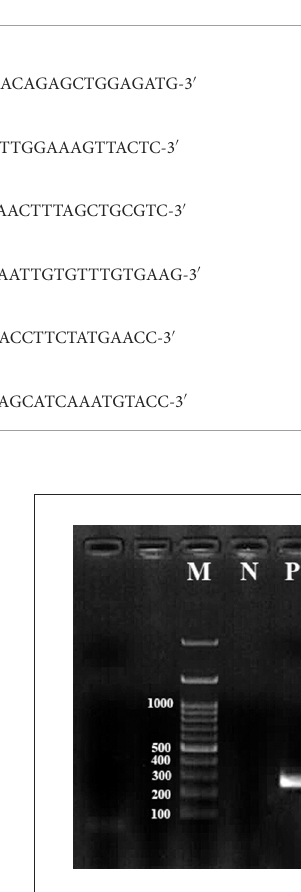
FIGURE1 The bands formed as a result of PCR amplification of the Cpa (alpha toxin encoding gene) gene fragment of Clostridium perfringens cattle isolates corresponding to approximately 247 bp in size. M, Marker (100 bp); P, Positive control; N, Negative control; BK1 and BK2, Clostridium perfringens alpha toxin encoding gene.